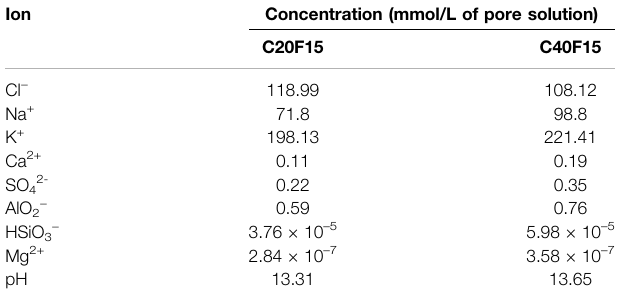
TABLE 7 | Ionic concentration and pH of pore solution of CACs with C20F15 and C40F15.